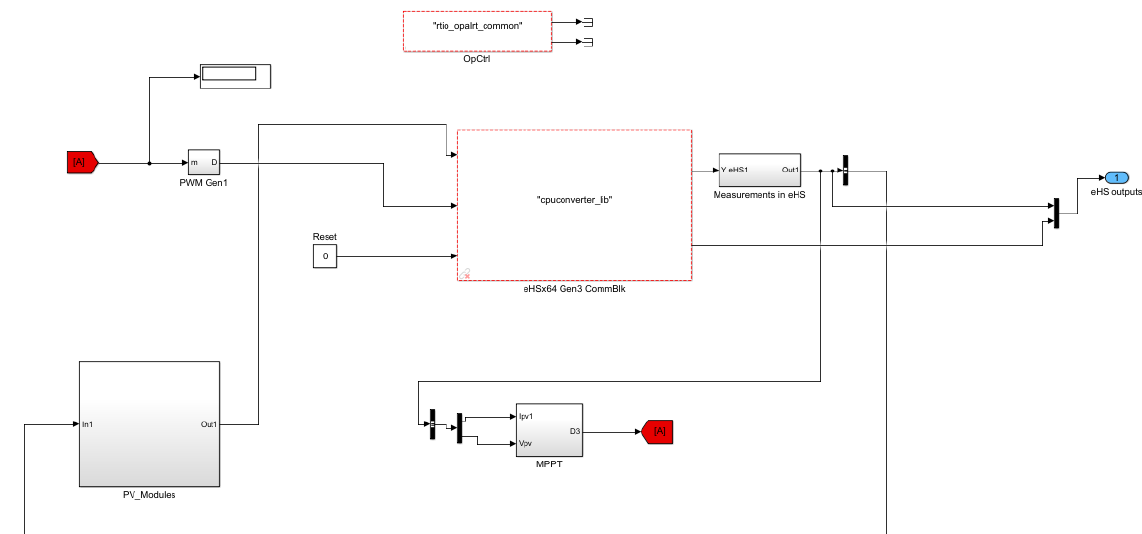
Figure 26. OPAL-RT Modeling Testing Experimentation.